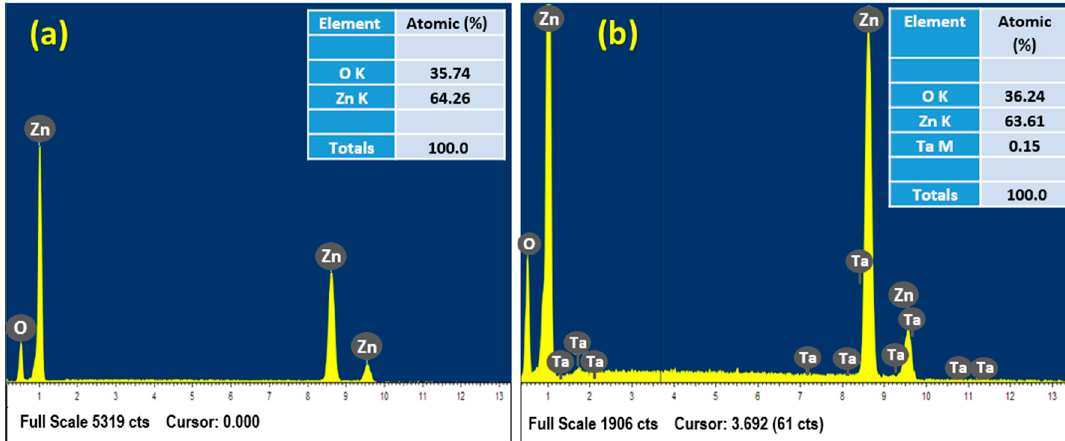
Figure 10. X-ray spectrometry (EDS) analysis for ( a ) undoped ZnO film, and ( b ) ZnO:Ta-doped film grown with 300 mg of Ta 2 O 5 in the pellet source.